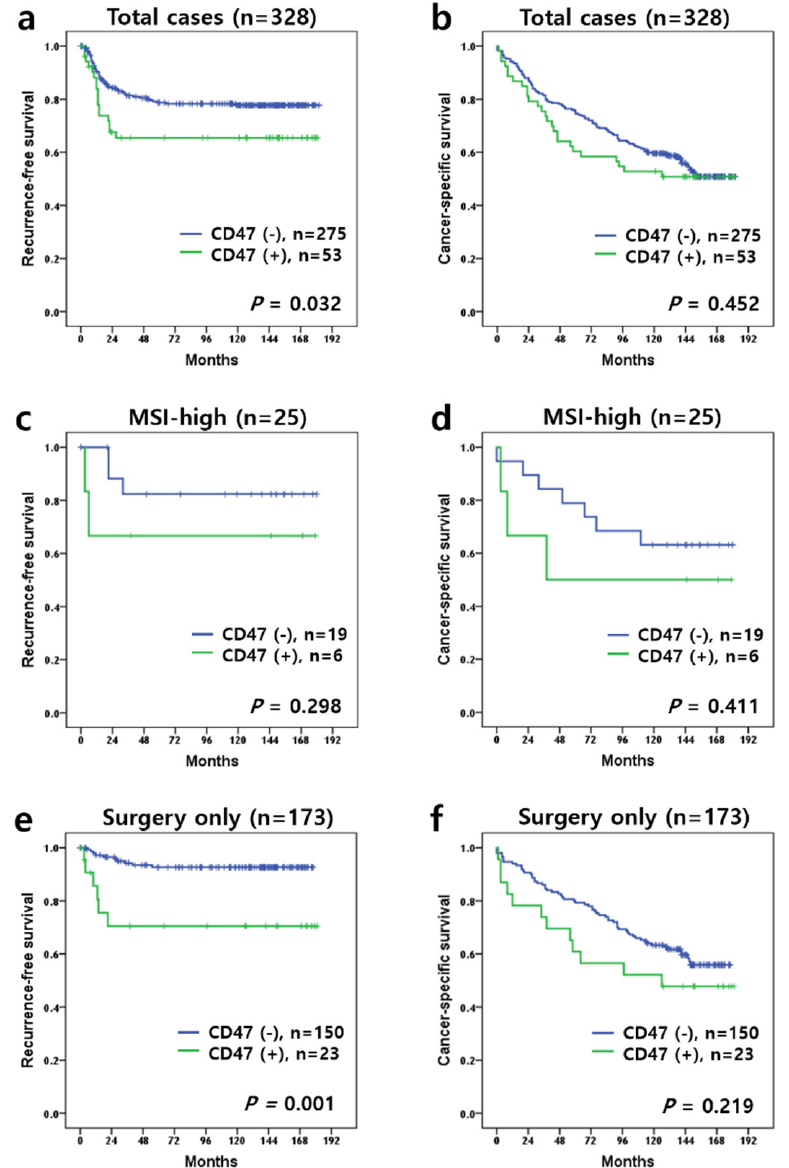
Figure 2. Kaplan–Meier survival curves of colorectal adenocarcinoma patients stratified based on CD47 expression. ( a ) Recurrence-free survival (RFS) and ( b ) cancer-specific survival (CSS) in all patients. ( c ) RFS and ( d ) CSS in MSI-high patients. ( e ) RFS and ( f ) CSS in patients who received surgical resection without adjuvant treatment.